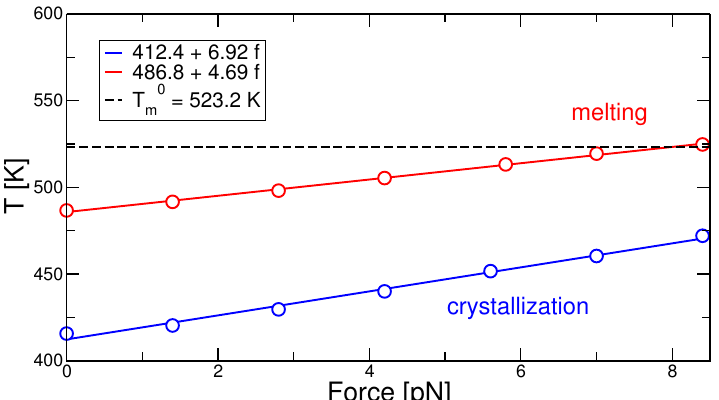
Figure 5. Crystallization and melting temperature as a function of the applied force taken from the inflection point of the heating/cooling data of Figure 4. The dashed lines indicate the extrapolated equilibrium melting temperature, T 0 m (cid:39) 523.2 K.